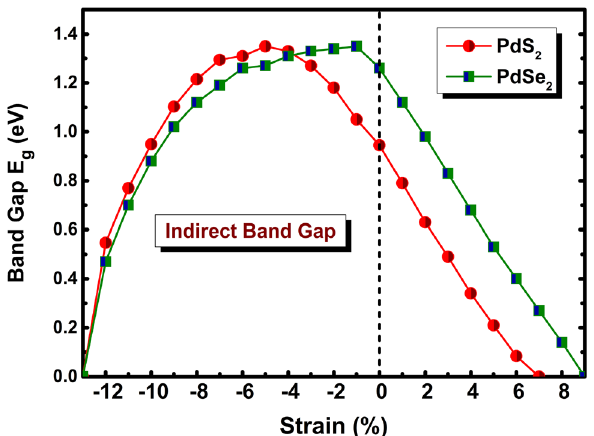
Figure 4. The variation of band gap E g ( eV ) with applied biaxial strain ε ( % ) on penta-PdQ 2